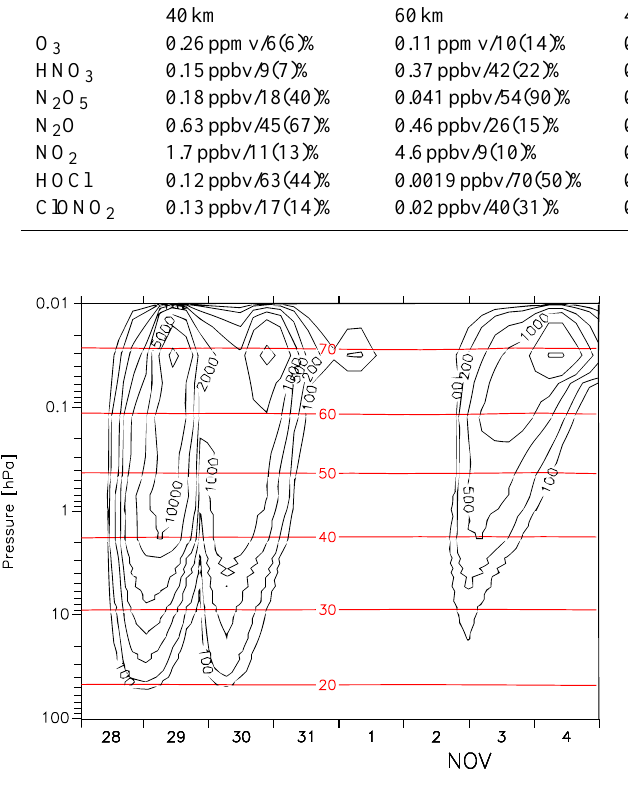
Fig. 2. Calculated high-latitude (70 ◦ –90 ◦ N zonal average) ioniza- tion rates (#cm − 3 s − 1 ) during October and November 2003. The red lines denote the altitude inkm.